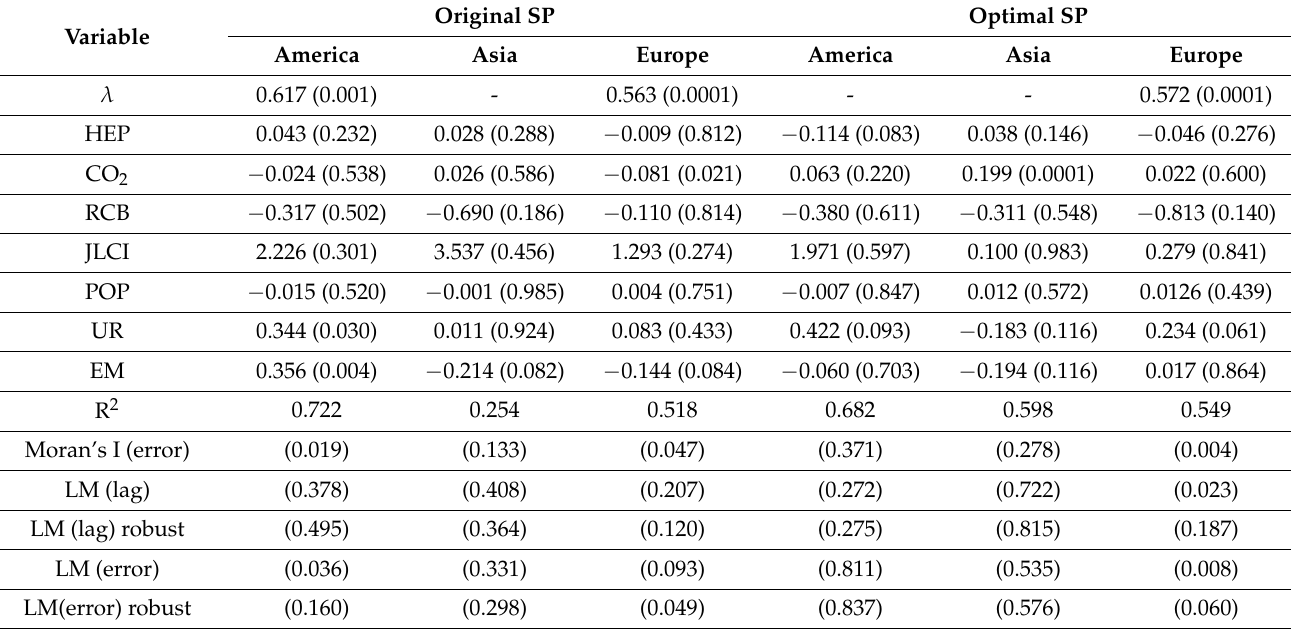
Table 6. Estimation results for system performance (new and optimised) for different continents.